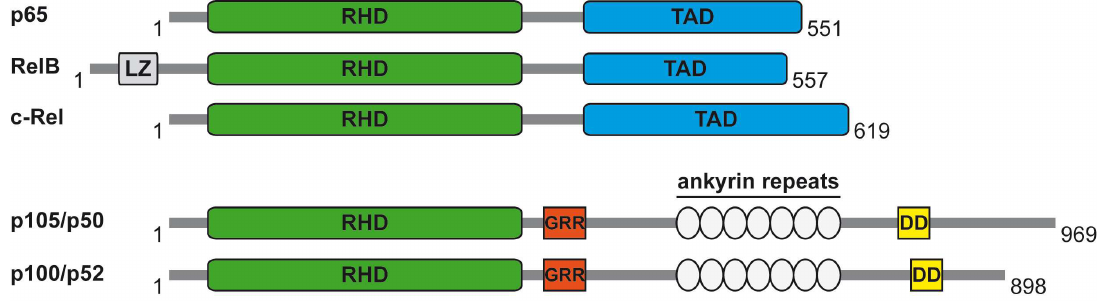
Figure 1. DNA-binding subunits of NF-κB. The functional domains of the five DNA-binding subunits, including the leucine zipper (LZ), the glycine-rich region (GRR), and the death domain (DD) are shown. The number of amino acids is given for the human proteins.